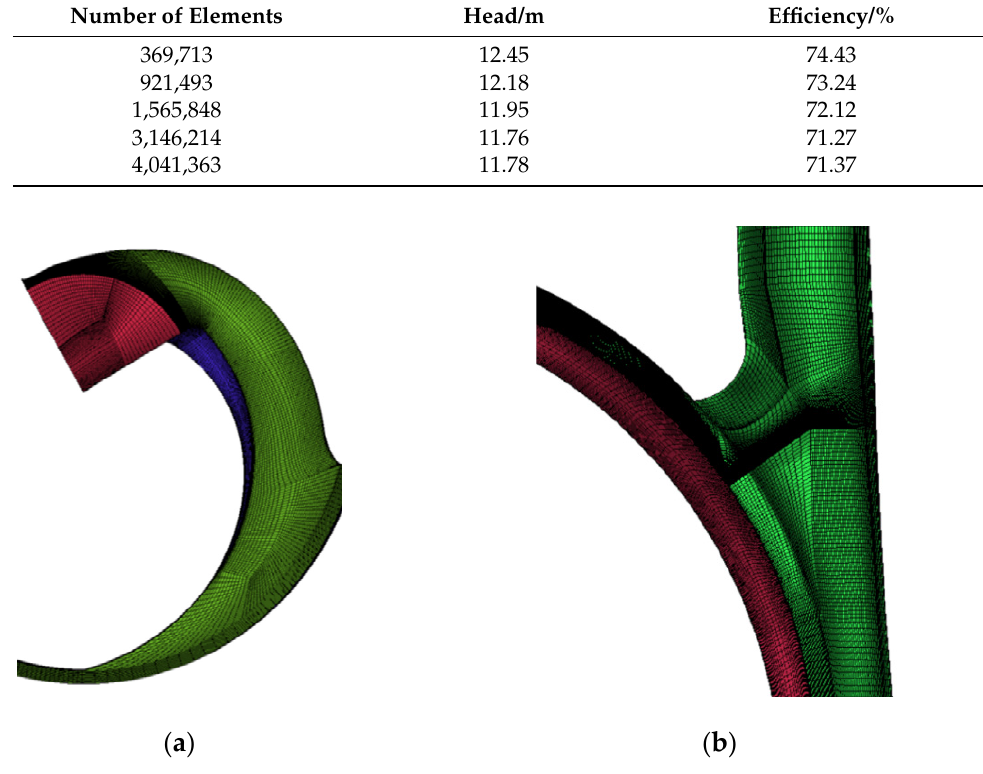
Figure 2. Grid generation of the computing domain: ( a ) impeller; ( b ) volute. Table 2. Grid independence analysis.